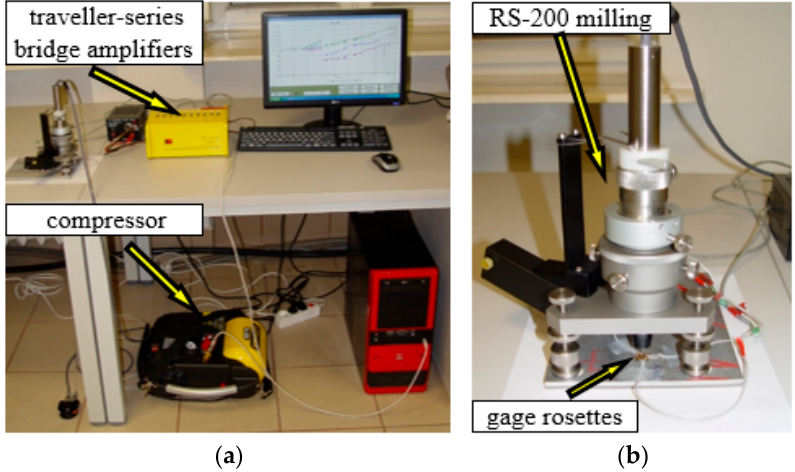
Figure 6. The overall view of testing stand ( a ) and the milling guide of RS-200 ( b ).